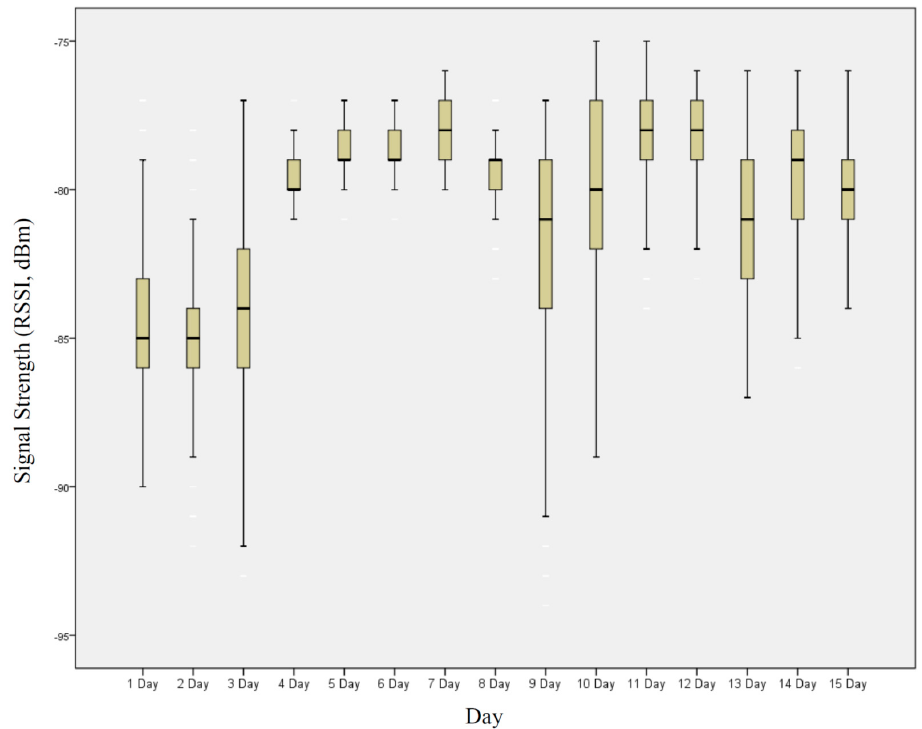
Figure A2. Box plot of signal strength for each day.